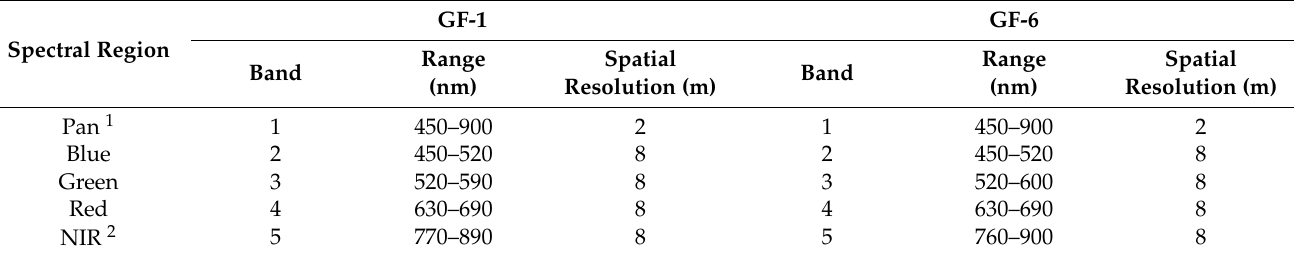
Table 2. Bands of GF-1 and GF-6.